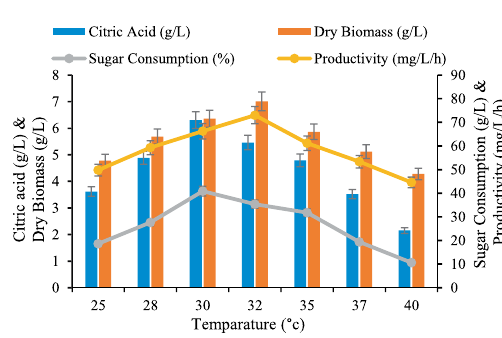
Fig. 4. Effect of pH for the citric acid production Fig. 5. Effect of temperature on citric acid production.